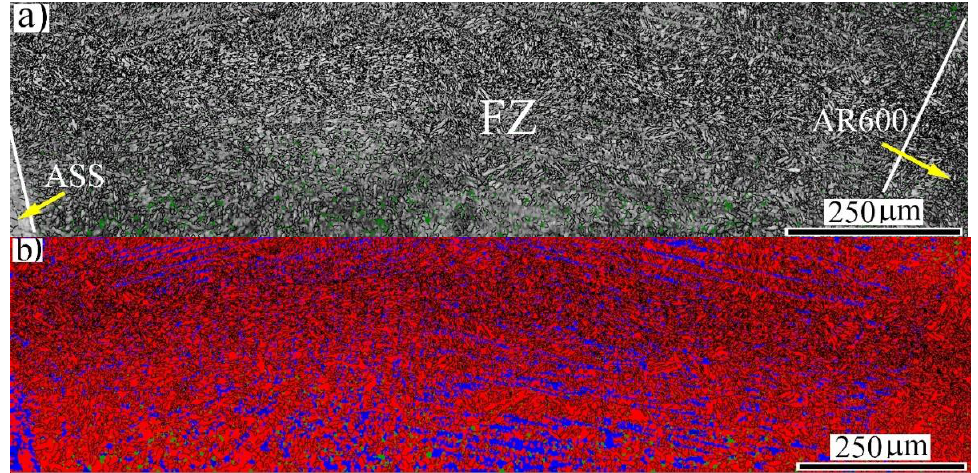
Figure 7. General view of the microstructure across the weld section of the dissimilar laser-welded butt joint at 320 J/mm: ( a ) EBSD IQ map; ( b ) EBSD phase map with indexing of α (cid:48) - bct in red and γ - fcc austenite in blue.